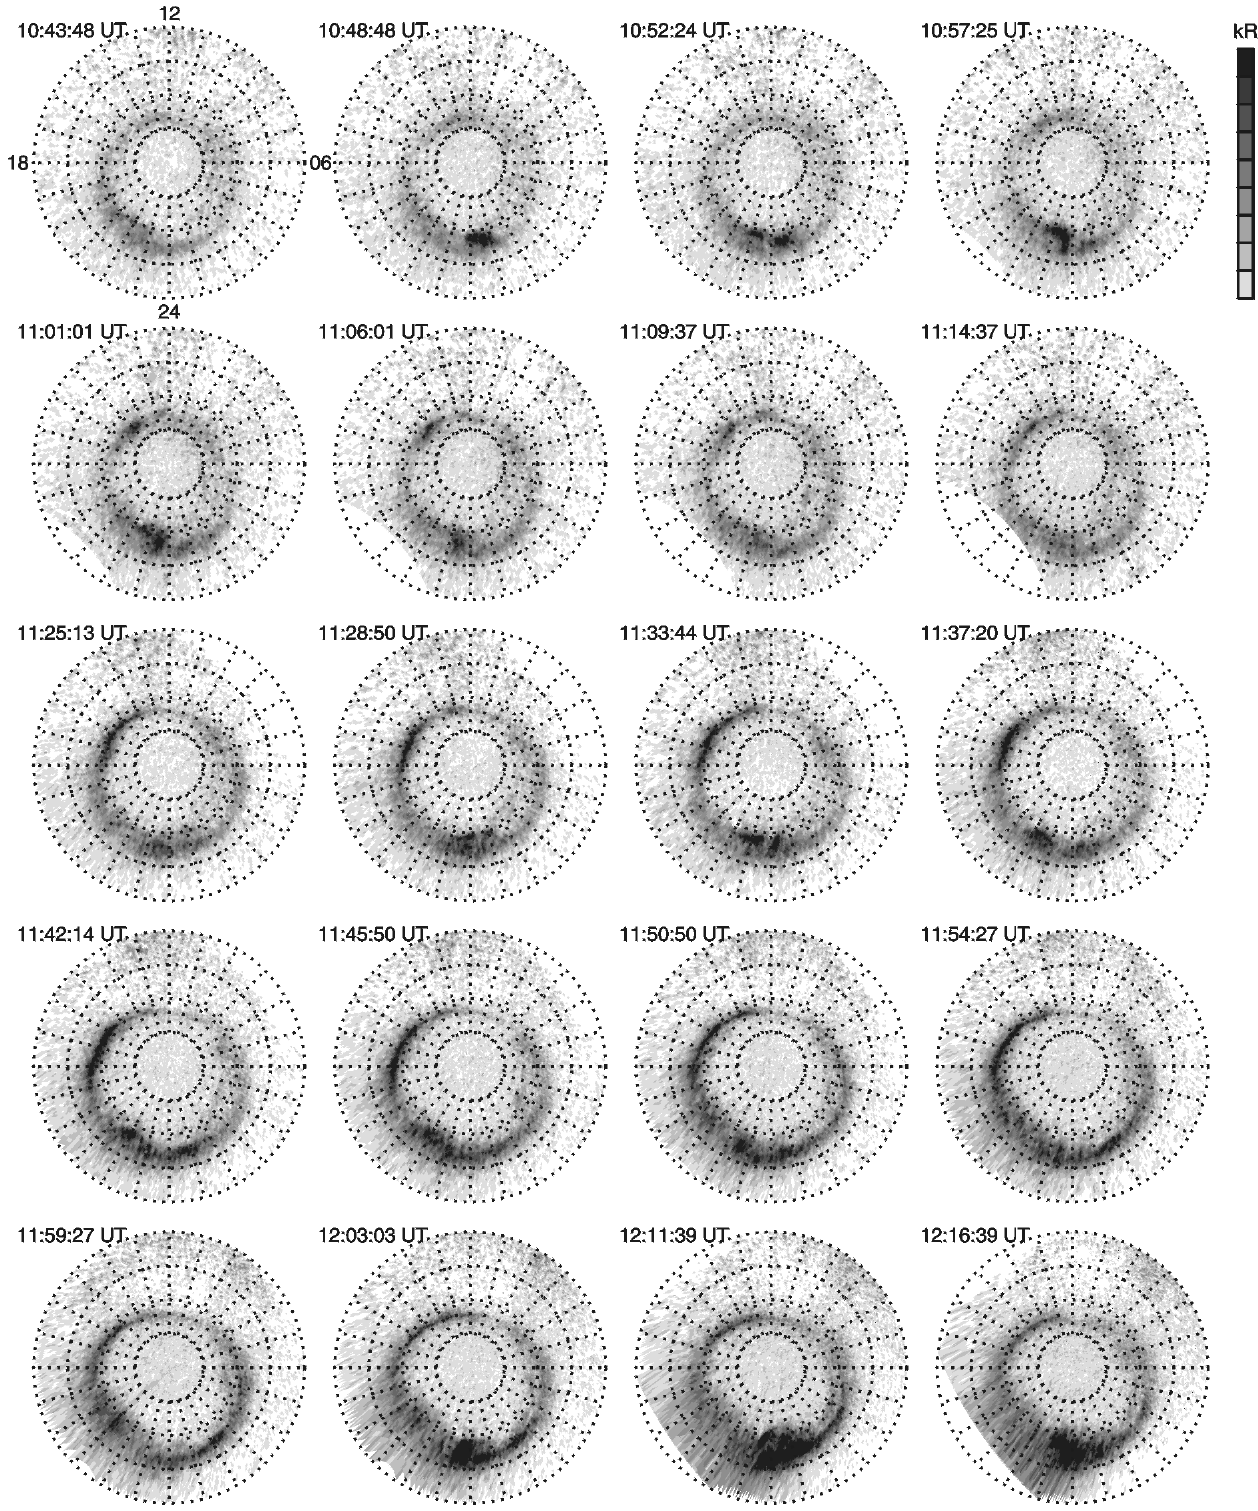
Fig. 3. The development of the northern hemisphere ultraviolet aurora captured in the VIS Earth Camera images between 10:43:48 UT and 12:11:39 UT. Each straight dashed line denotes one hour of local time with 12 MLT towards the top of the figure, and each dashed concentric circle marks 10 ◦ in magnetic